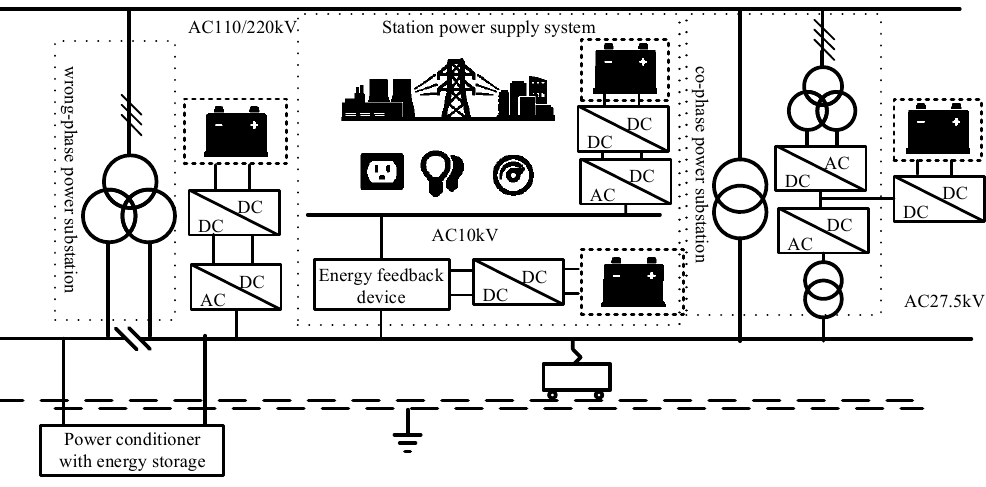
Figure 4. The AC traction energy system topology.